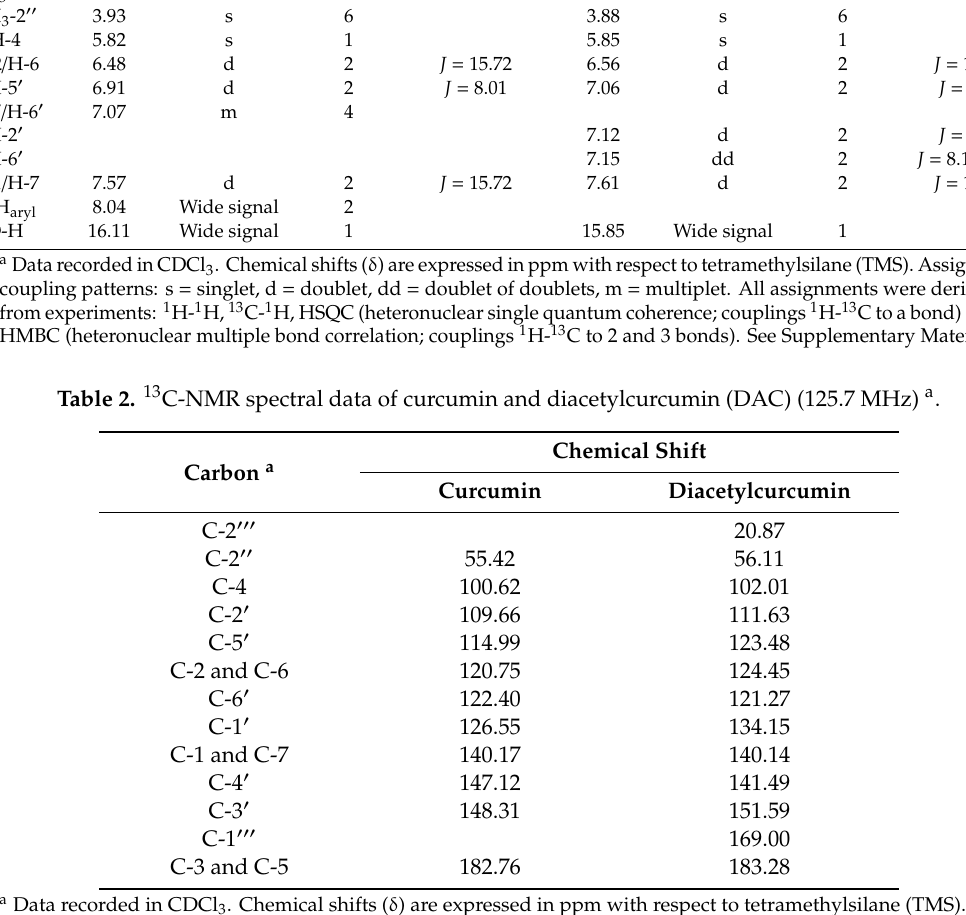
Table 1. 1 H-NMR spectral data of curcumin and diacetylcurcumin (DAC) (500 MHz) a .